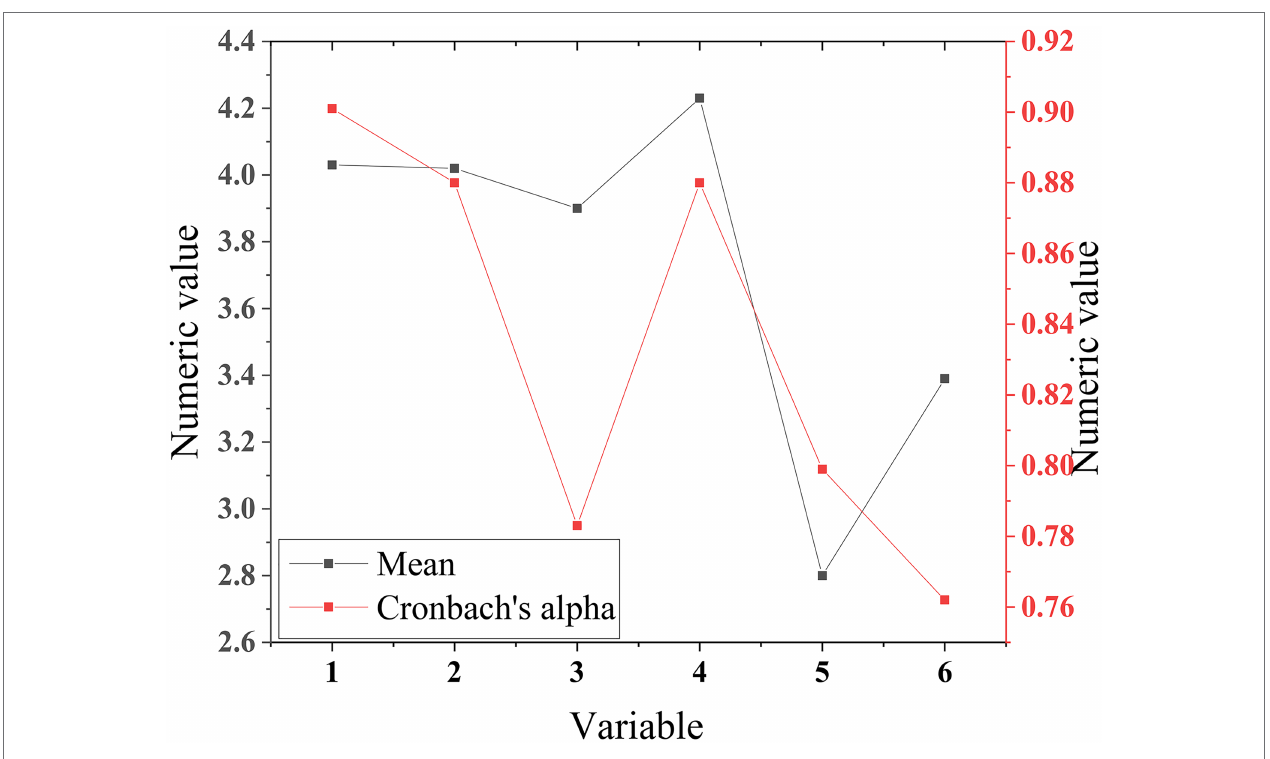
FIGURE 5 | Reliability test results of the QS.